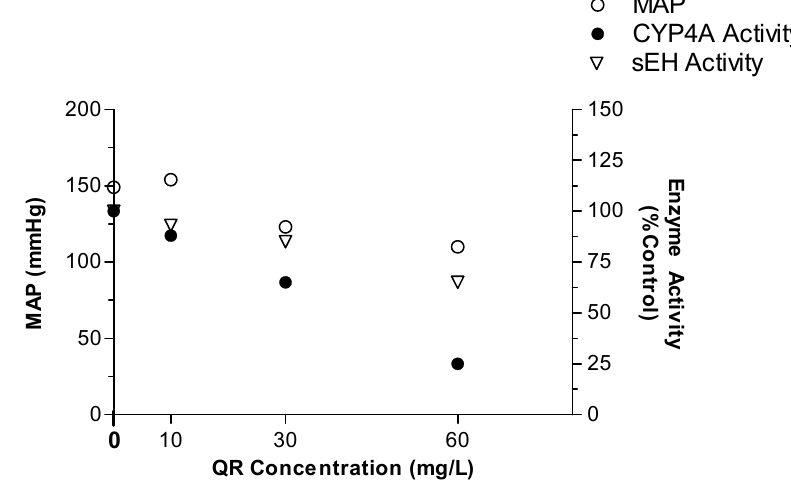
Figure 6. The association between dose-dependent changes in CYP4A and sEH activity, and the changes in mean arterial blood pressure (MAP). Treatment rats received QR in their drinking water at concentrations of 10, 30, and 60 mg / L, for 7 weeks. Control rats received drinking water only (i.e., QR concentration is 0 mg/L).